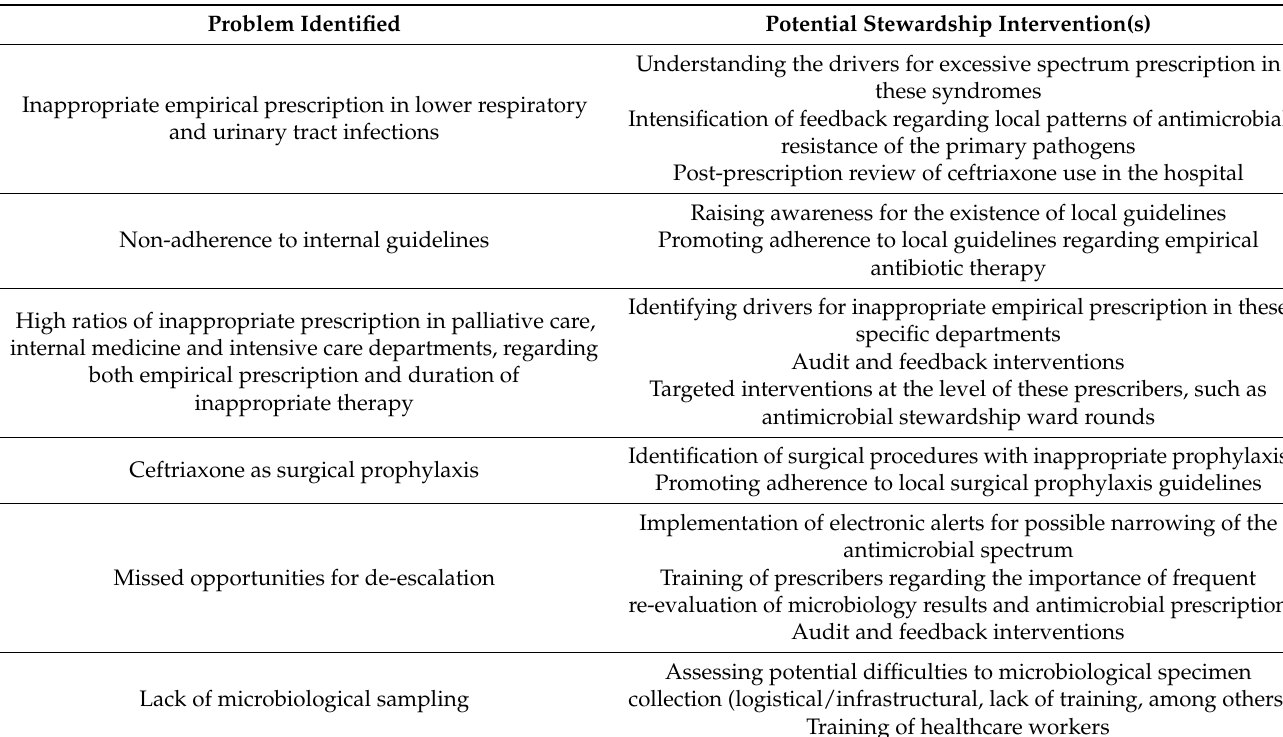
Table 5. Potential opportunities for antimicrobial stewardship interventions regarding ceftriaxone